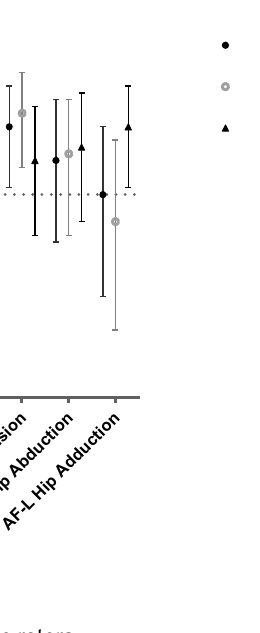
Figure 4. Relative intrarater reliability of EasyForce for three raters.